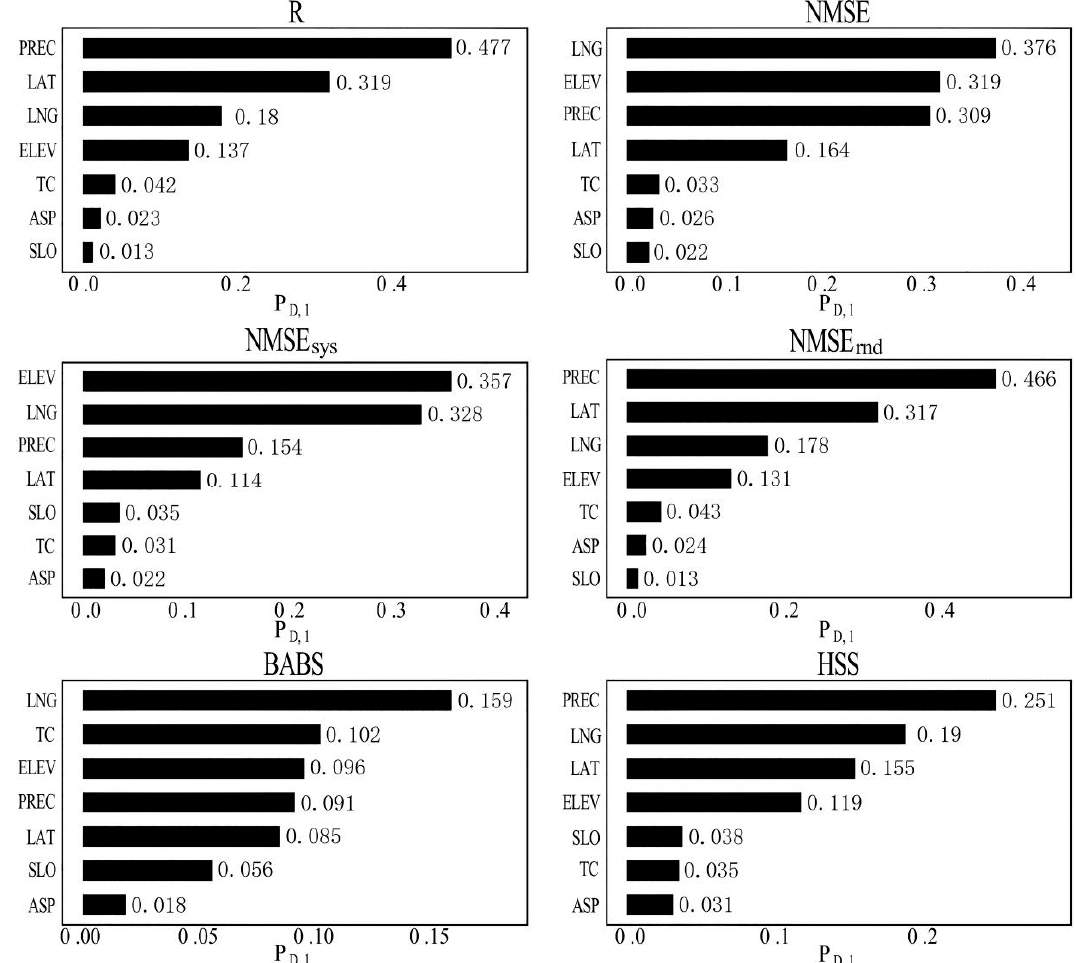
Figure 11. Result of the factor detector of accuracy